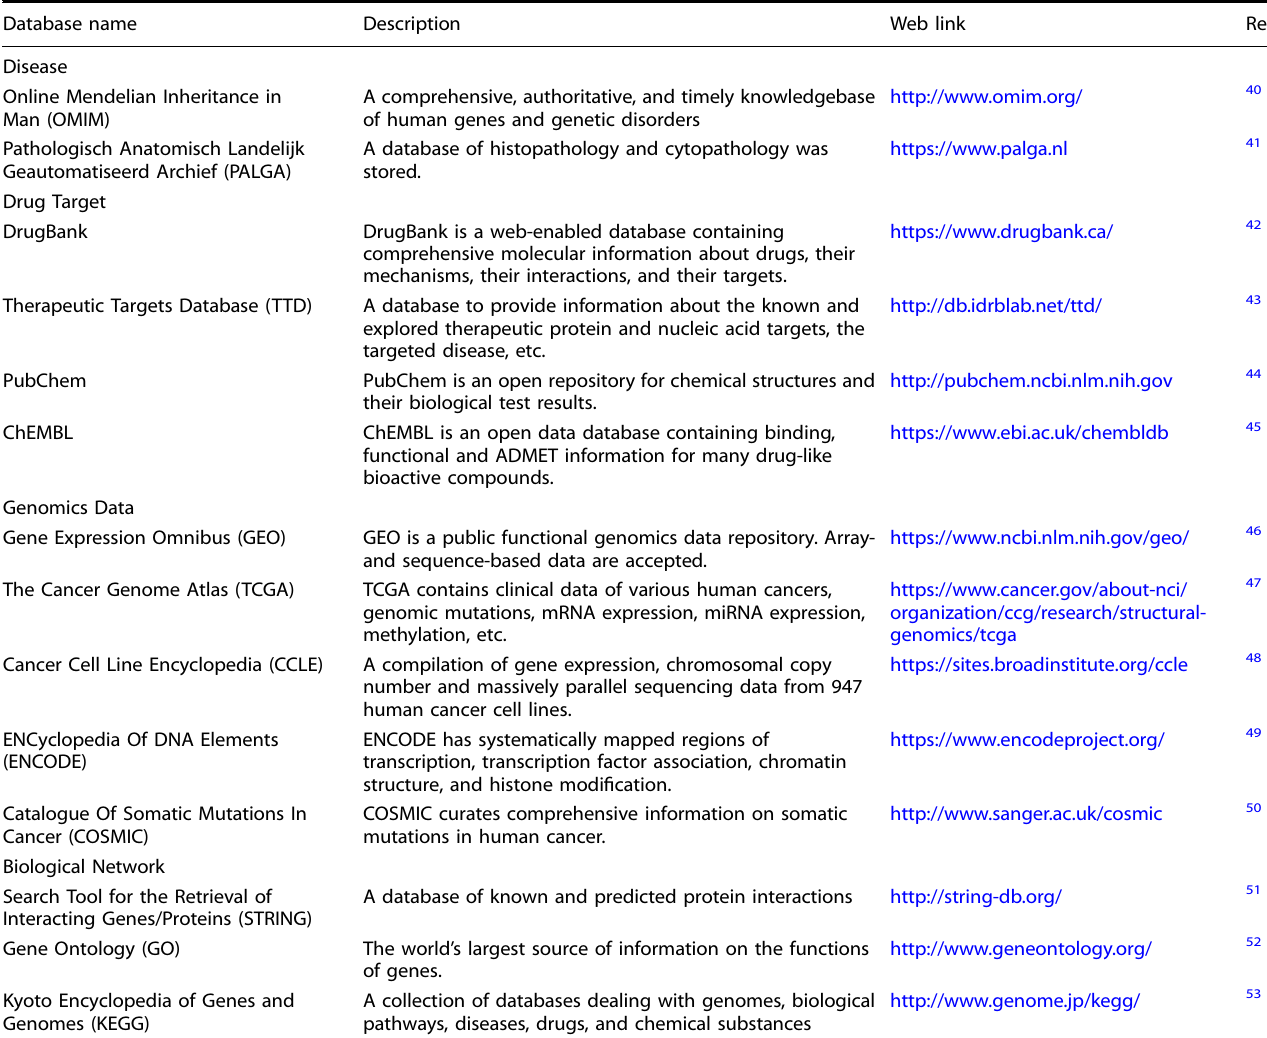
Table 1. Commonly used repositories related to human diseases, drug targets, genomics, and biological